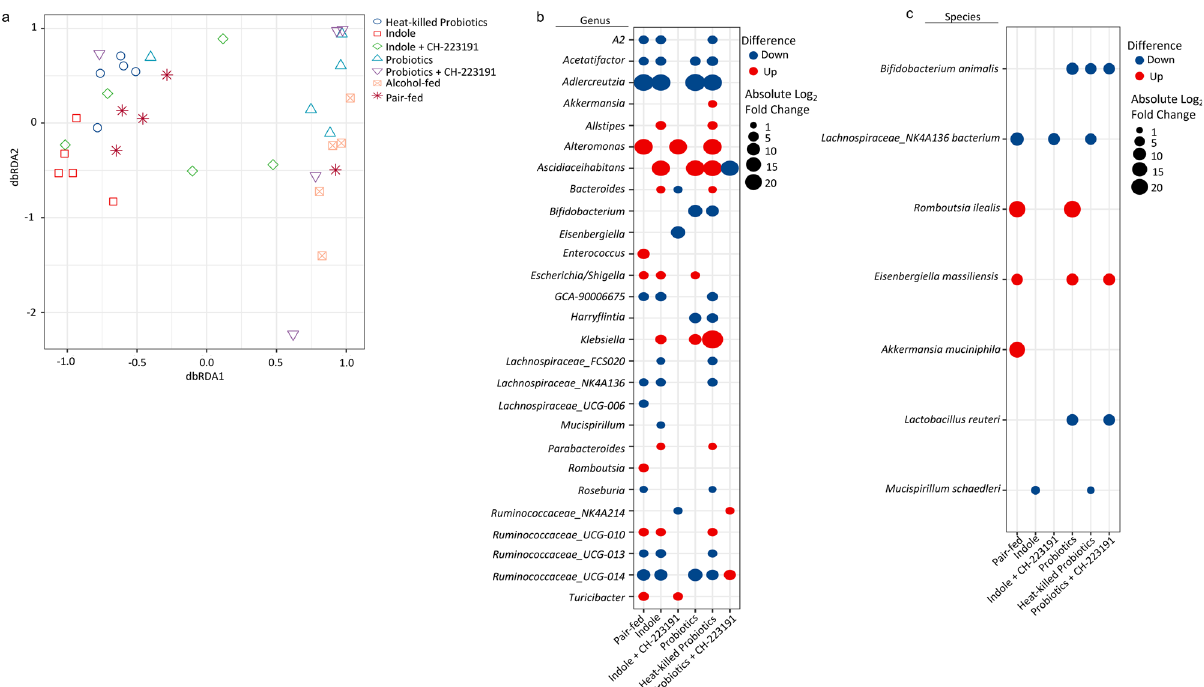
Fig. 9 Indole and probiotics alter the intestinal microbial structure of alcohol-fed mice. Binge-on-chronic alcohol-fed mice with and without treatment were infected with Klebsiella and sacri fi ced 48 h post-infection. a Beta diversity of alcohol-fed mice with and without treatment, as determined by distance ‐ based redundancy analysis (dbRDA) on sample ‐ wise Bray – Curtis dissimilarity distances. Differentially abundant OTUs at the b genus or c species level as determined by DESeq2 using a negative binomial generalized linear models for each taxa and Wald test for signi fi cances. For each comparison (i.e., columns): taxa with a blue dot (down) indicates that the taxa is decreased in alcohol-fed animals compared to the indicated treatment (i.e., pair-fed, indole, etc.), while taxa with a red dot (up) indicates that the taxa is enriched in alcohol-fed mice compared to the indicated treatment. Absolute indicates the magnitude of the log2fold change. N =